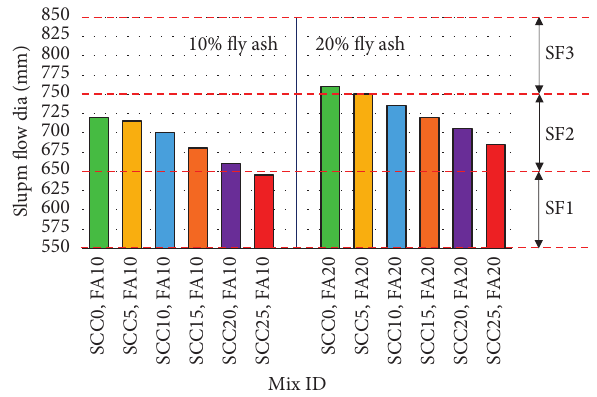
Figure 1: Slump values for the fresh concrete.